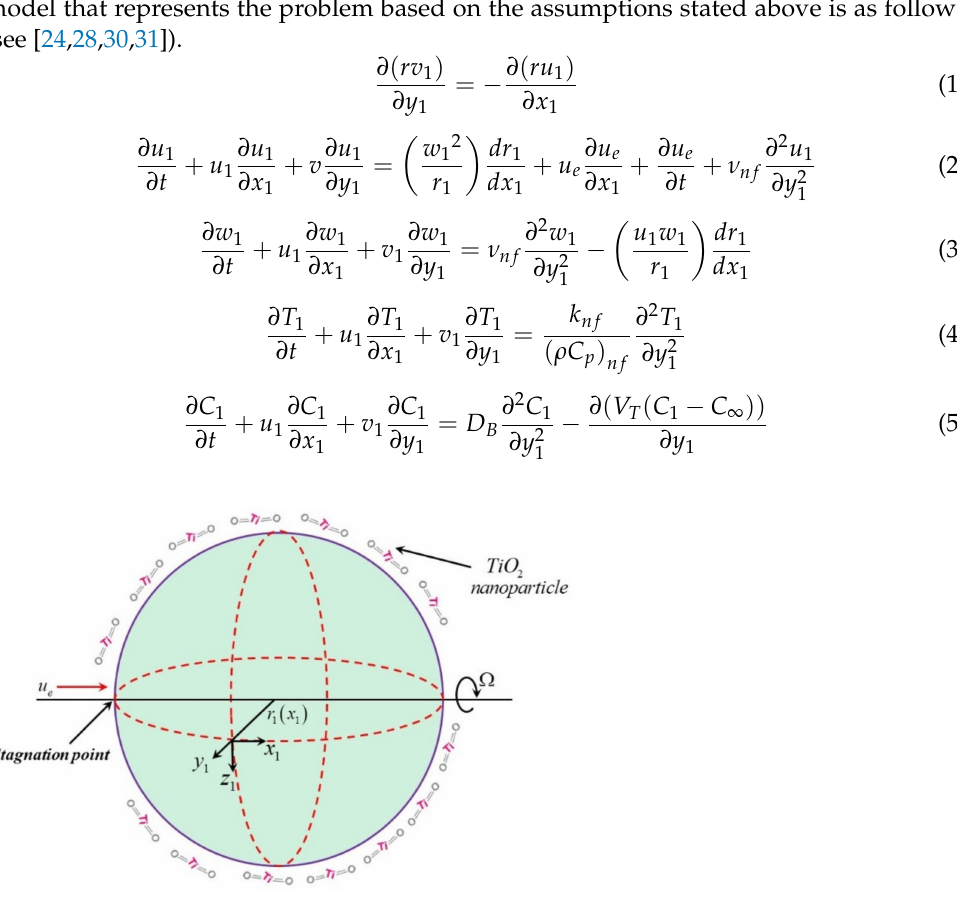
Figure 1. Geometry of the